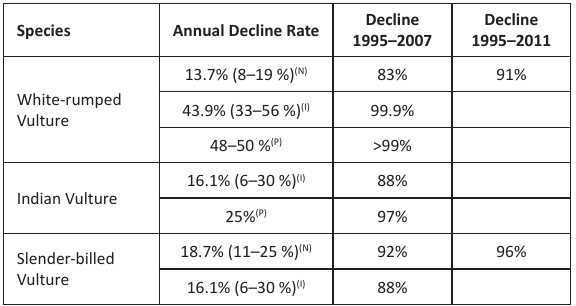
Table 2. Estimated Rates of Decline of White-rumped Vulture, Indian Vulture and Slender-billed Vulture in Nepal (N) , India (I) and Pakistan (P) . Adapted from available data (Gilbert et al. 2006; Prakash et al. 2007; Pain et al. 2008; Chaudhary et al. 2012) Species